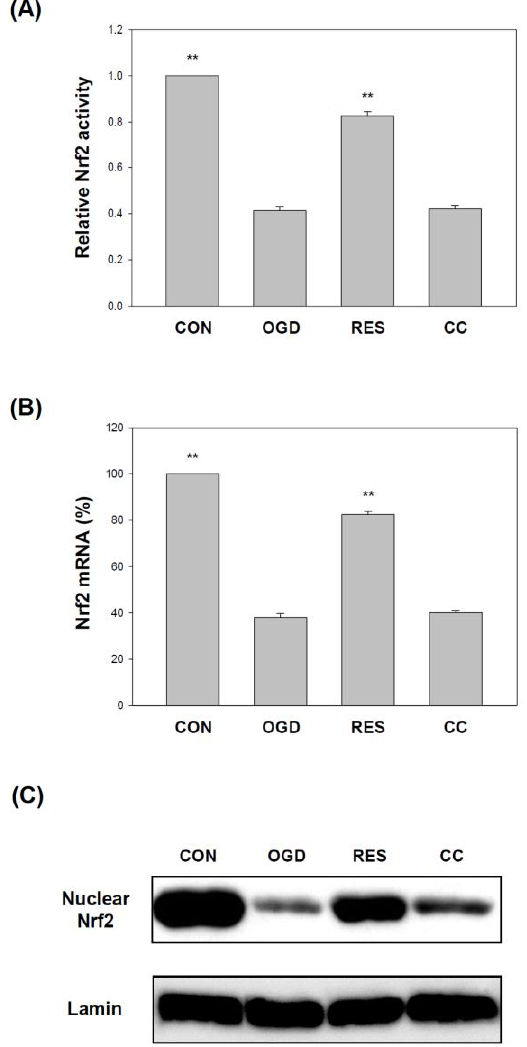
Figure 8. Resveratrol normalized Nrf2 activity and genes by OGD in 3D scaffolds. The cell experiments under the scaffolds were divided into four groups, as described in Figure 1 and in the methods section. The Nrf2 level was detected by the Nrf2 transcription factor assay ( A ). ( B ) qPCR was used to analyze the Nrf2 mRNA level in each treatment group. ( C ) Collect nuclear components (20 µ g per lane) from the specified conditions and perform the level of Nrf2 protein by Western blot analysis. Values are expressed as percentages of the indicated level in CON and are presented as the mean ± SEM values from three independent experiments. Specific comparison to the indicated SH-SY5Y cells with OGD ** p < 0.001 vs. cells with